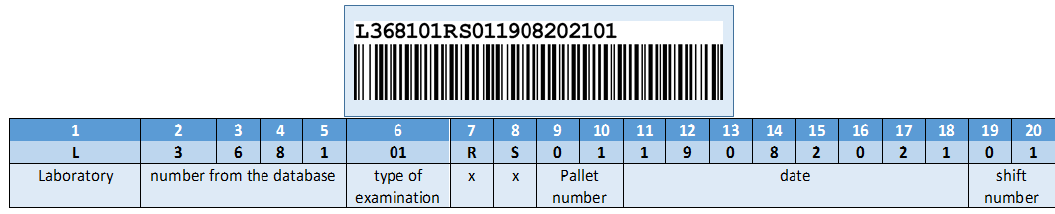
Figure 13. Sample pallet marking with barcode according to GS-1 128 standard (see content for details).